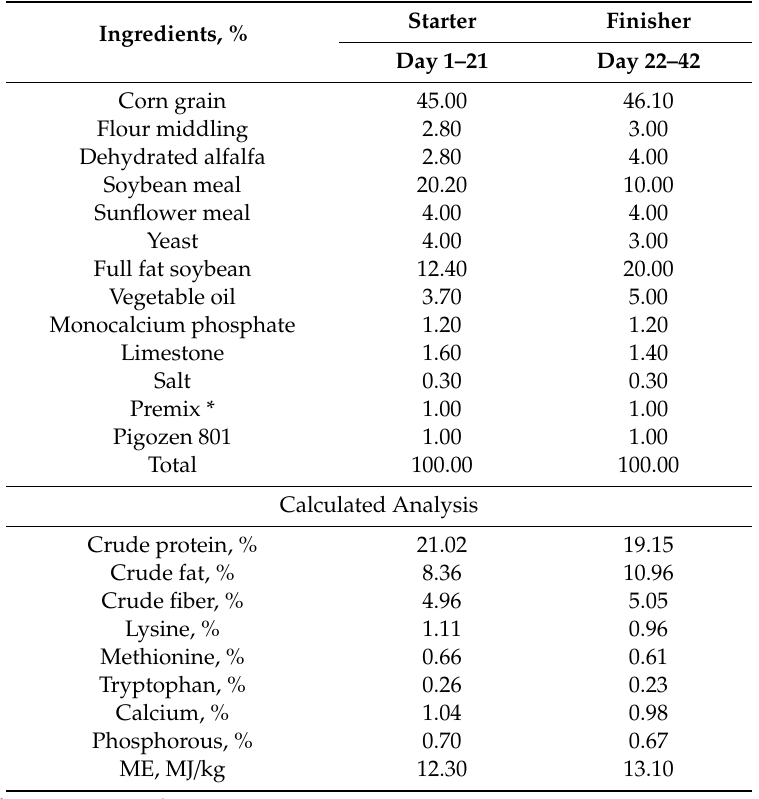
Table 1. The composition and calculated analysis of feed mixtures used in the feeding of the broilers.